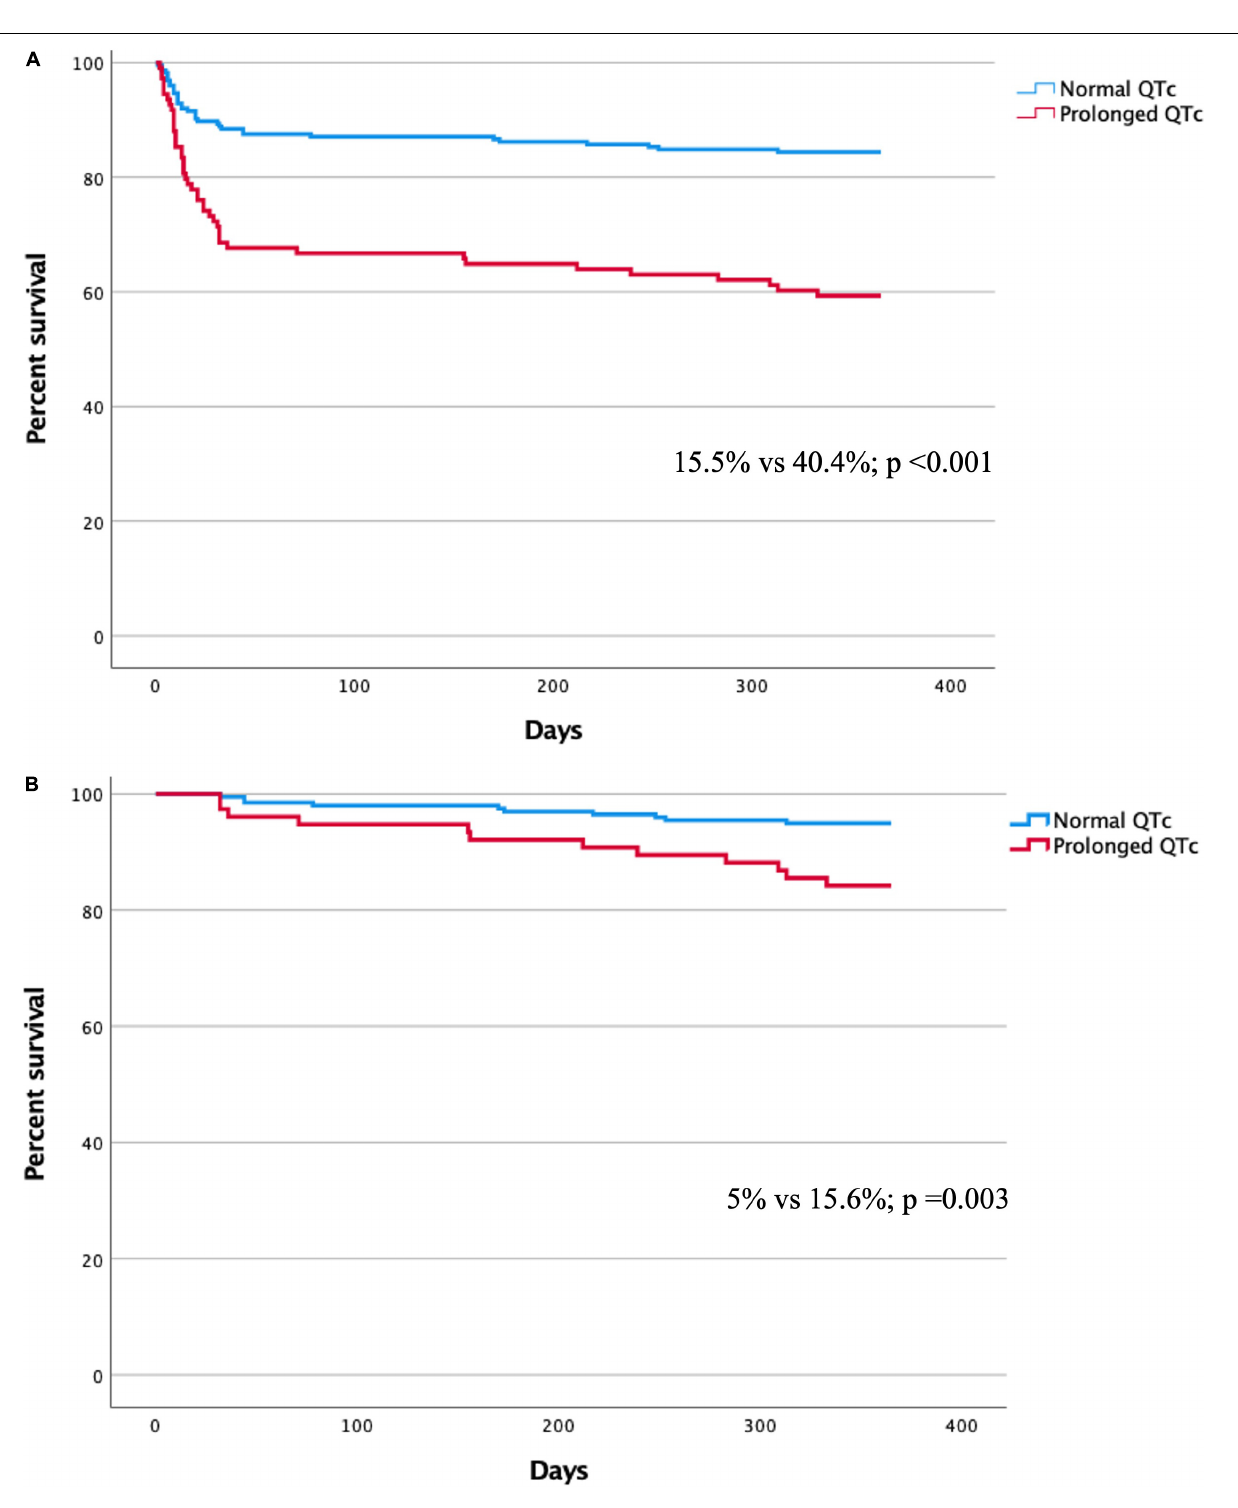
Frontiers in Cardiovascular Medicine |